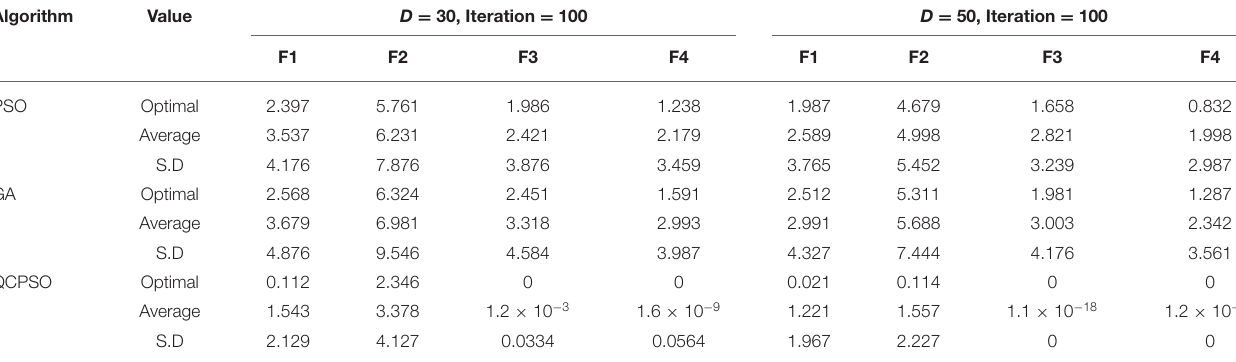
TABLE 1 | Value for three Algorithms. Algorithm